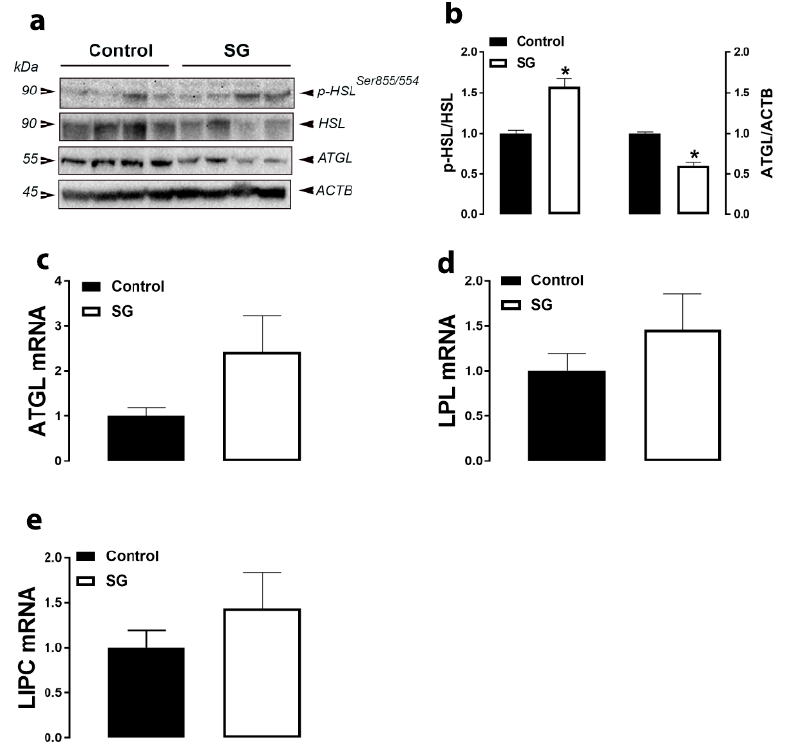
Figure 4. Effect of SG on the expression of lipolysis-related proteins and genes in adipose tissue. Protein levels ( a , b ) were measured by Western blot and mRNA abundances ( c – e ) were determined by qPCR using the 2 − ∆∆ Ct method [21]. Data are presented as the mean ± SEM ( n = 8 birds/ group). * Denotes significant difference compared to the control group at p < 0.05. ATGL, adipose triglyceride lipase; HSL, hormone-sensitive lipase; LPL, lipoprotein lipase; LIPC, lipase C.